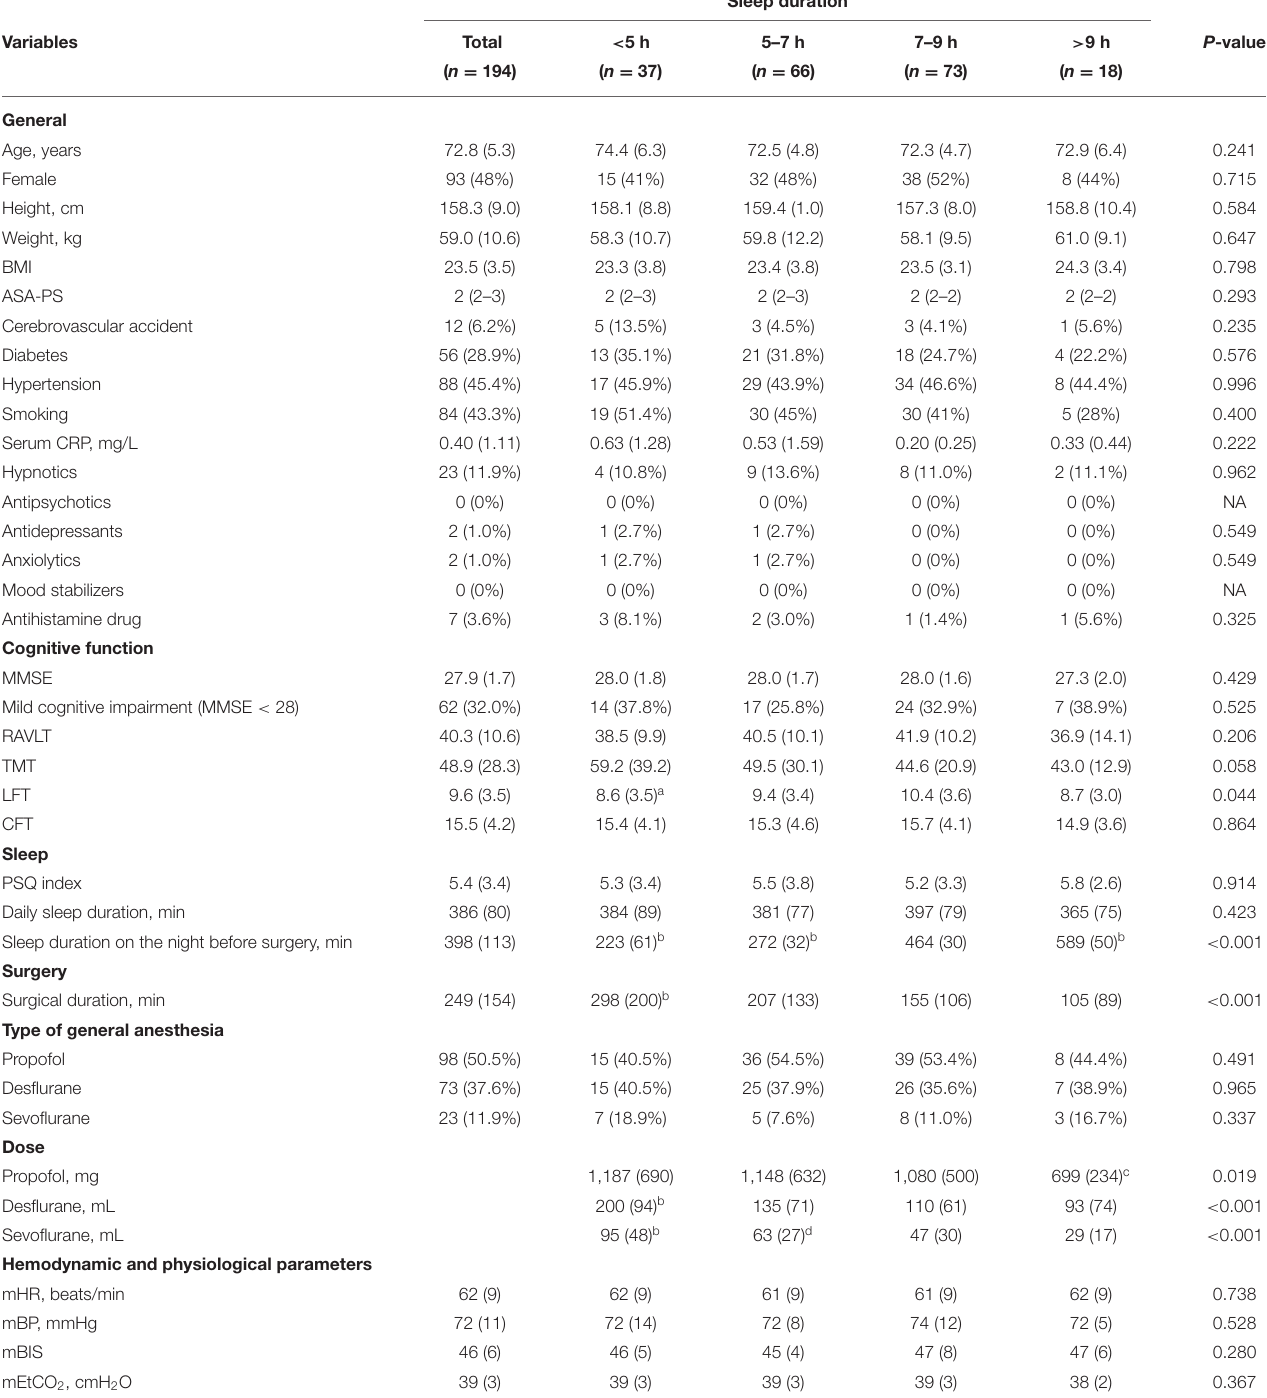
TABLE 1 | Participants’ preoperative